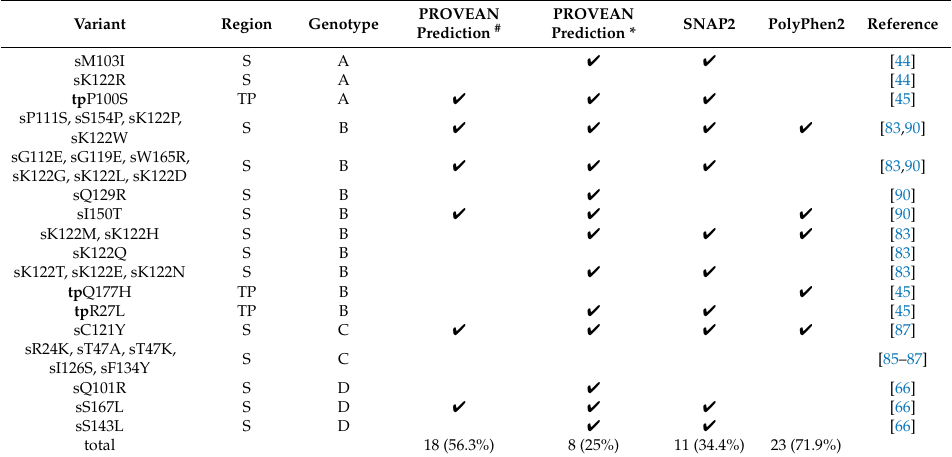
Table 2. Predicted effects of functionally characterized neutral mutations of HBV from literature. Variant